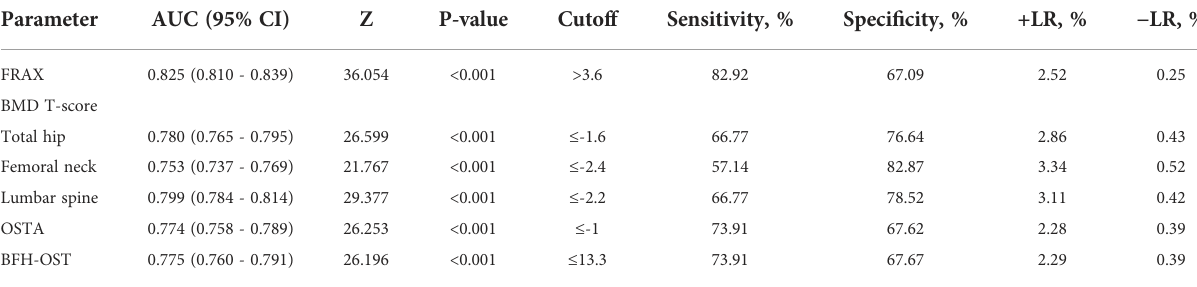
TABLE 4 AUC and sensitivity and speci fi city values of the FRAX, BMD T-score, OSTA, and BFH-OST for identifying PNOVFs.